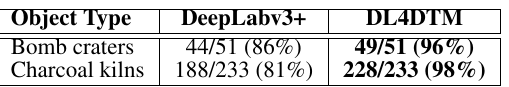
Table 3. Detection rates for DeepLabv3+ and DL4DTM for each object